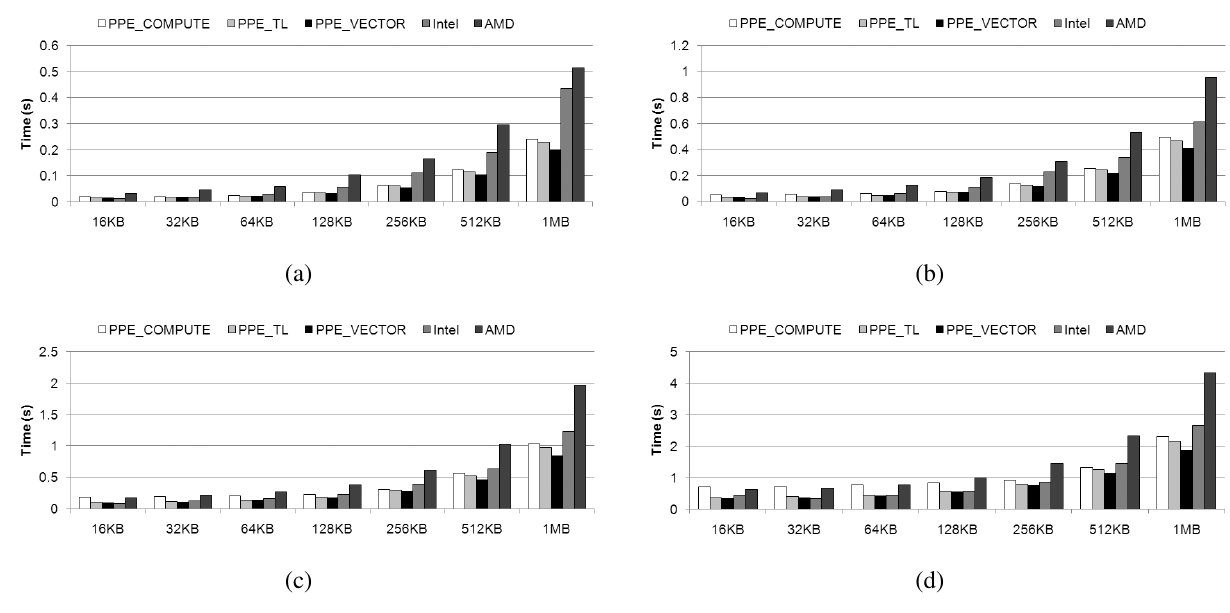
Figure 17. Decoding time on real machine with varying coefficient matrix size; ( a ) 64 × 64; ( b ) 128 × 128; ( c ) 256 × 256; and ( d ) 512 × 512.